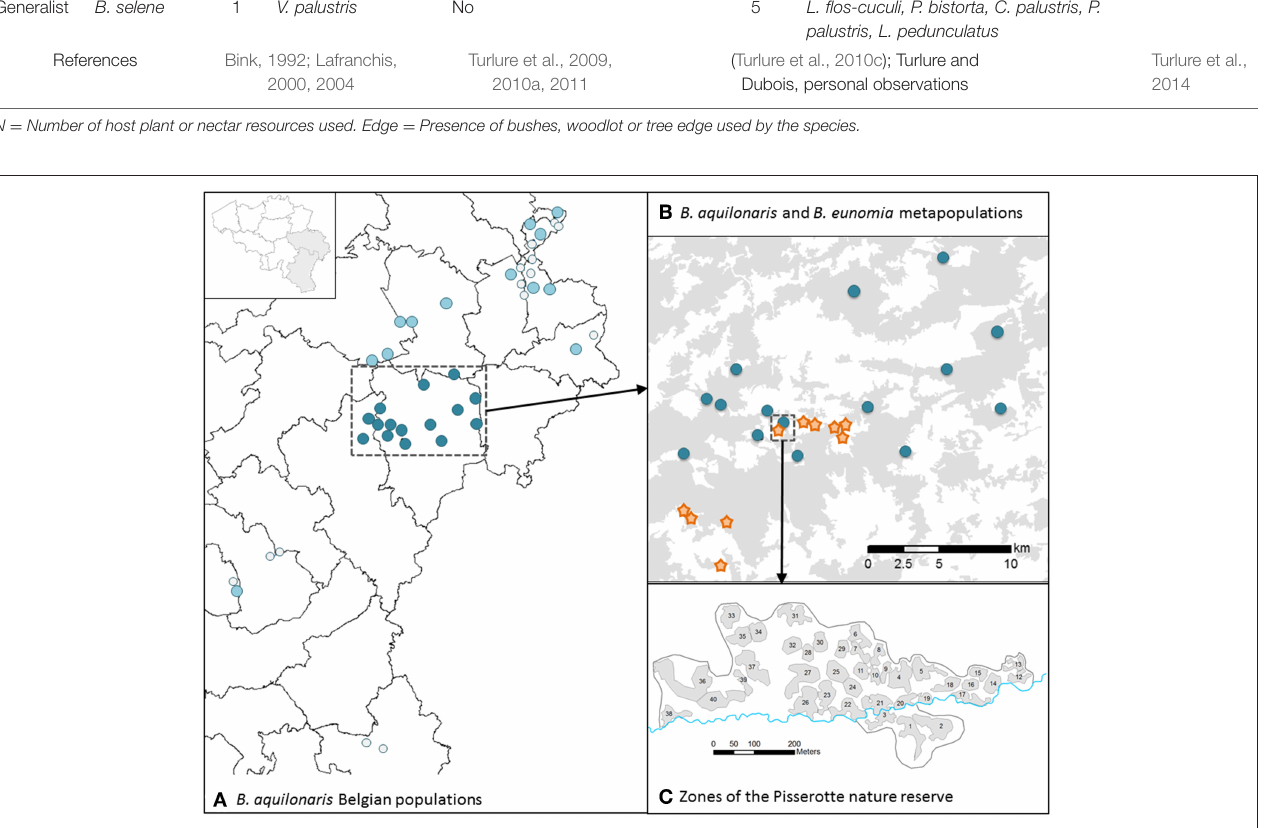
FIGURE 2 | Maps of the study sites. (A) Location of all Belgian B. aquilonaris populations in the Ardenne region (SE-Belgium). Dark blue dots: studied populations in the plateau des Tailles area. Light blue dots: other studied populations in Belgium. Light gray dots: other known populations. (B) Location of the studied populations for the B. aquilonaris (dark blue dots) and B. eunomia (orange stars) metapopulations in the plateau des Tailles area. (C) Location of the 40 zones (gray areas) in the Pisserotte nature reserve, where the five species were